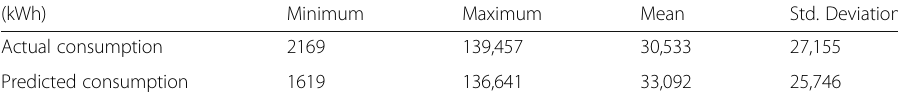
Table 8 Descriptive statistics between actual and predicted consumption (kWh) (kWh) Minimum Maximum Mean Std. Deviation Actual consumption 2169 139,457 30,533 27,155 Predicted consumption 1619 136,641 33,092